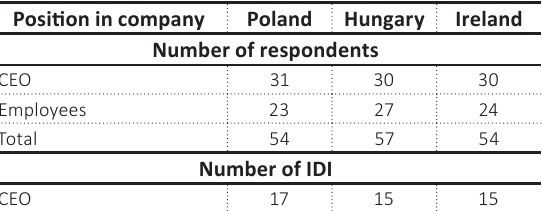
Source: Own study.